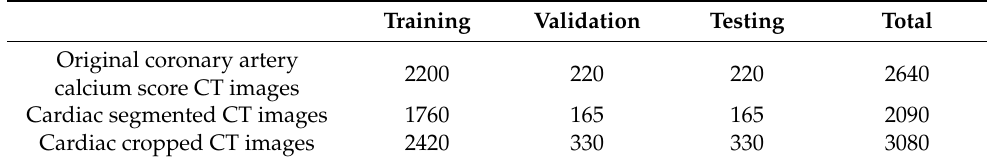
Table 2. Configuration of each